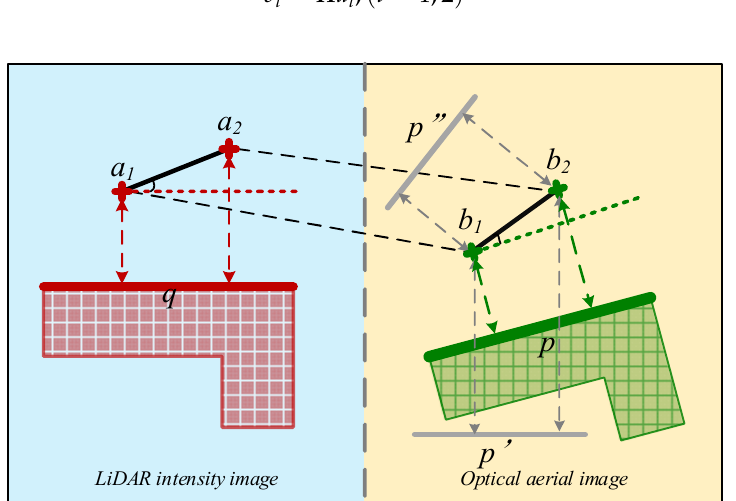
Figure 4. The corresponding relationship between points and lines in a local area.